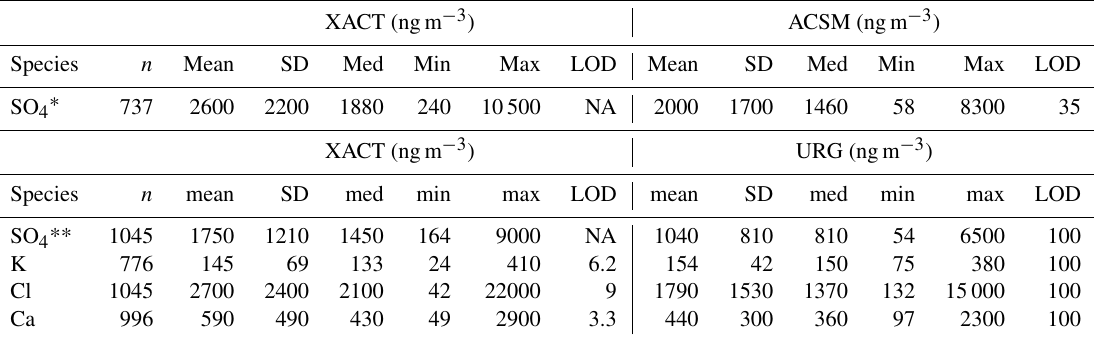
Table 6. Overview of Marylebone Road, London hourly SO 4 measurements in PM 2 . 5 by XACT and ACSM (ngm − 3 ); and hourly SO 4 , K, Cl, Ca measurements in PM10 by XACT and URG (ngm − 3 ); The asterisk ( ∗ ) denotes that SO 4 was calculated as non-sea salt SO 4 using S and Cl measurements; the asterisk ( ∗∗ ) denotes that SO 4 was calculated as predicted SO 4 using S measurements. XACT (ngm − 3